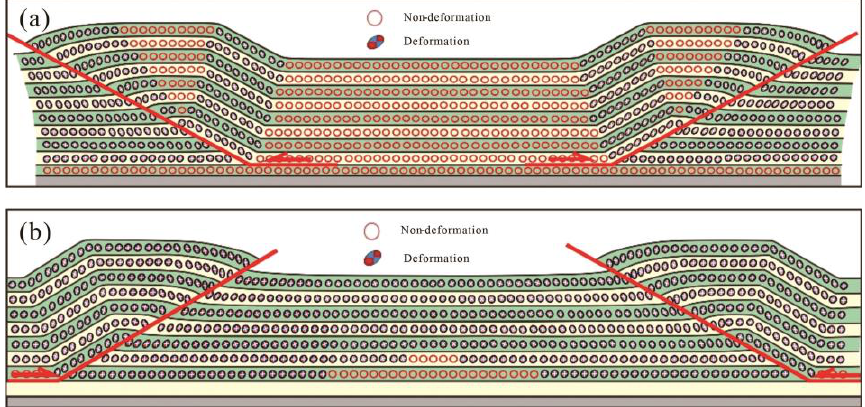
Figure 11. Internal strain distribution pattern of the structure in the Luzhou area. ( a ) Pop-up struc- ture; ( b ) delta structure. ( b ) delta